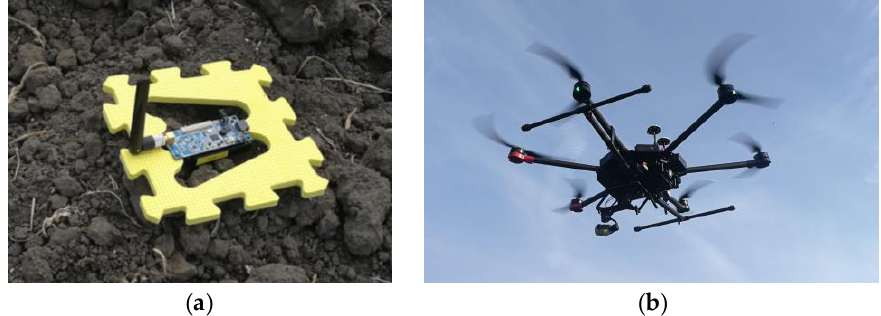
Figure 12. Equipment used in the experimental run. ( a ) Ground sensor node; ( b ) UAV. Table 3. DJI Matrice 600 PRO UAV main specifications.